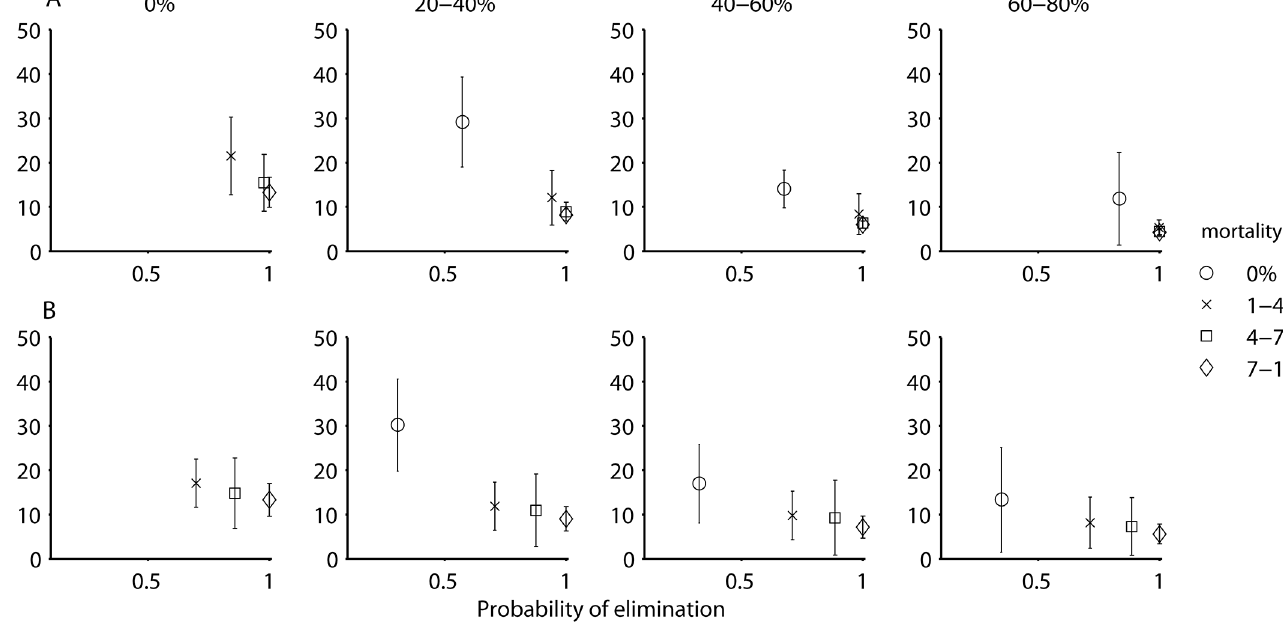
Fig 6. The proportion of simulations where HAT was eliminated (i.e., prevalence < 1 x 10 − 6 ) and the mean time to elimination, depending on the percentage of the human population screened per year, with varying levels of vector control (expressed as additional vector mortality, indicated by the symbols in the legend), for a moderate transmission setting without an animal reservoir (A) and with an animal reservoir (B).